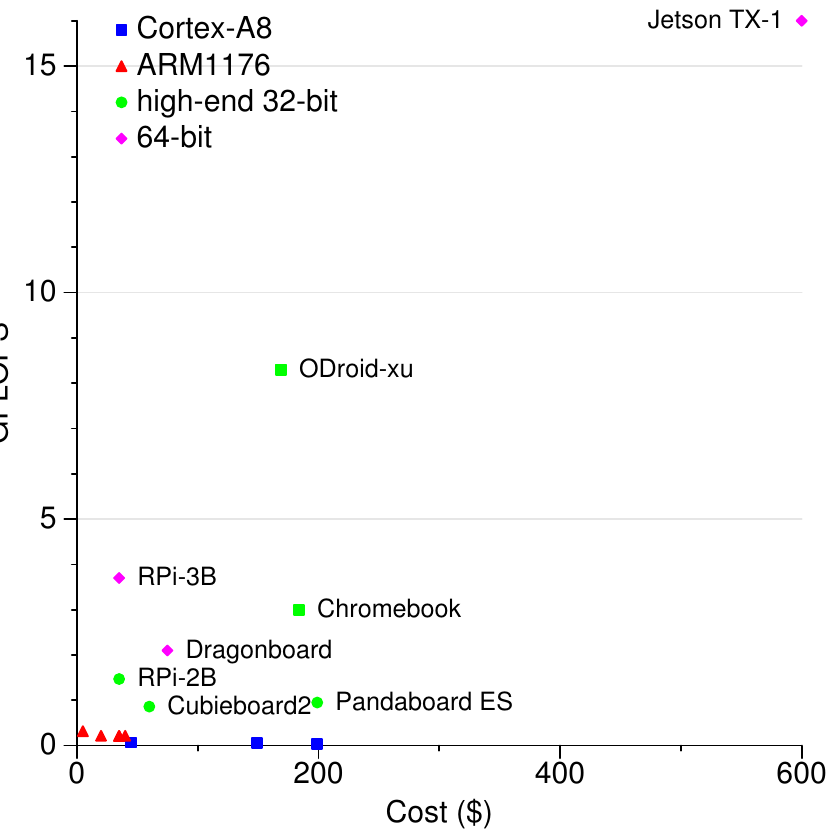
Figure 2. Performance (GFLOPS) compared to cost in US$. Upper left is the